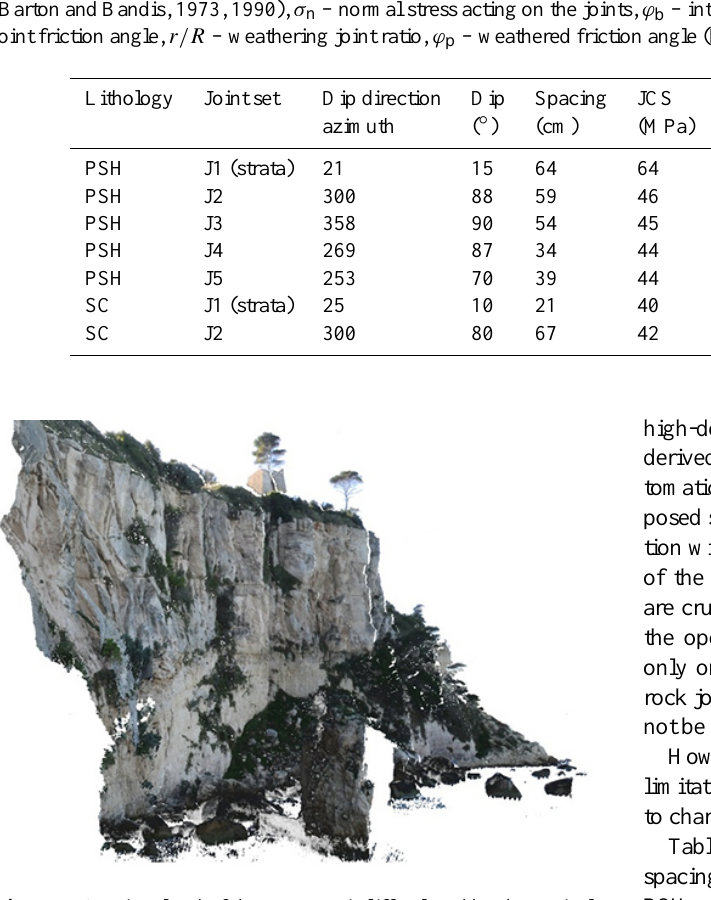
Fig. 5. TLS point cloud of the Mt. Pucci cliff colored by the optical